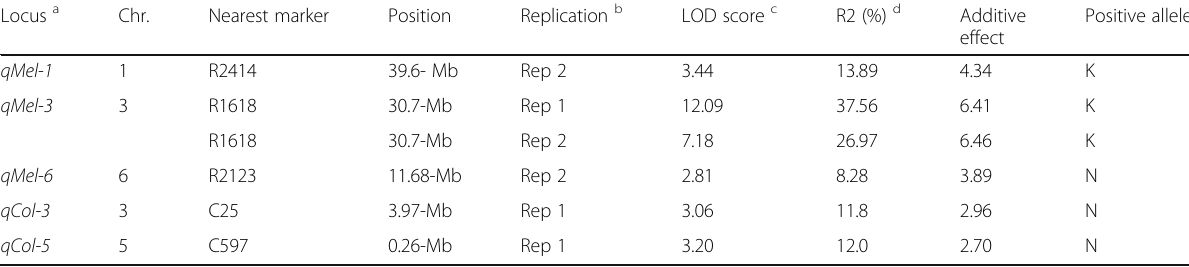
Table 1 Characteristics of QTLs for mesocotyl and coleoptile length in 98 BILs Locus a Chr. Nearest